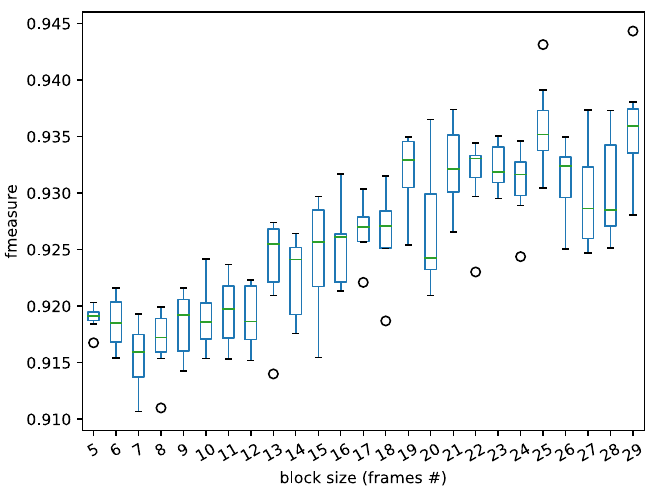
Figure 15. Performances of different block sizes as input of LRCN for the Jamendo dataset.